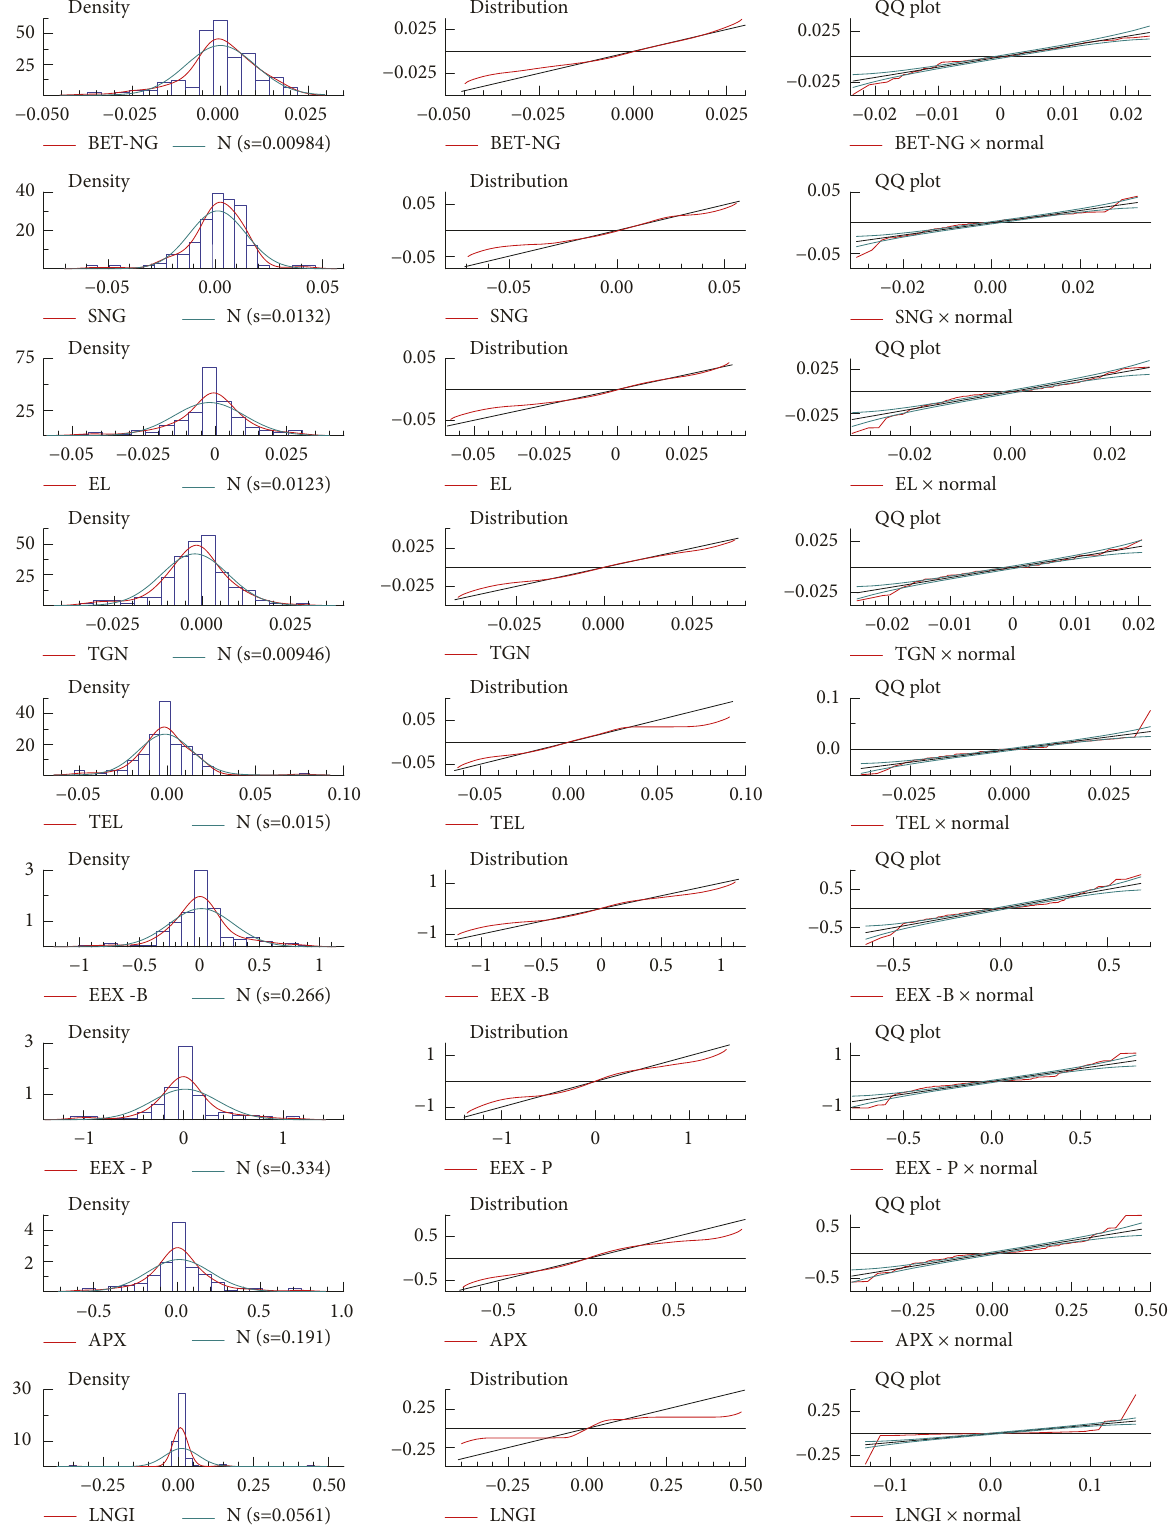
Figure 1: Density, distribution, and QQ plots for daily returns. Source: author’s own work. Notes: variables’ descriptions are provided